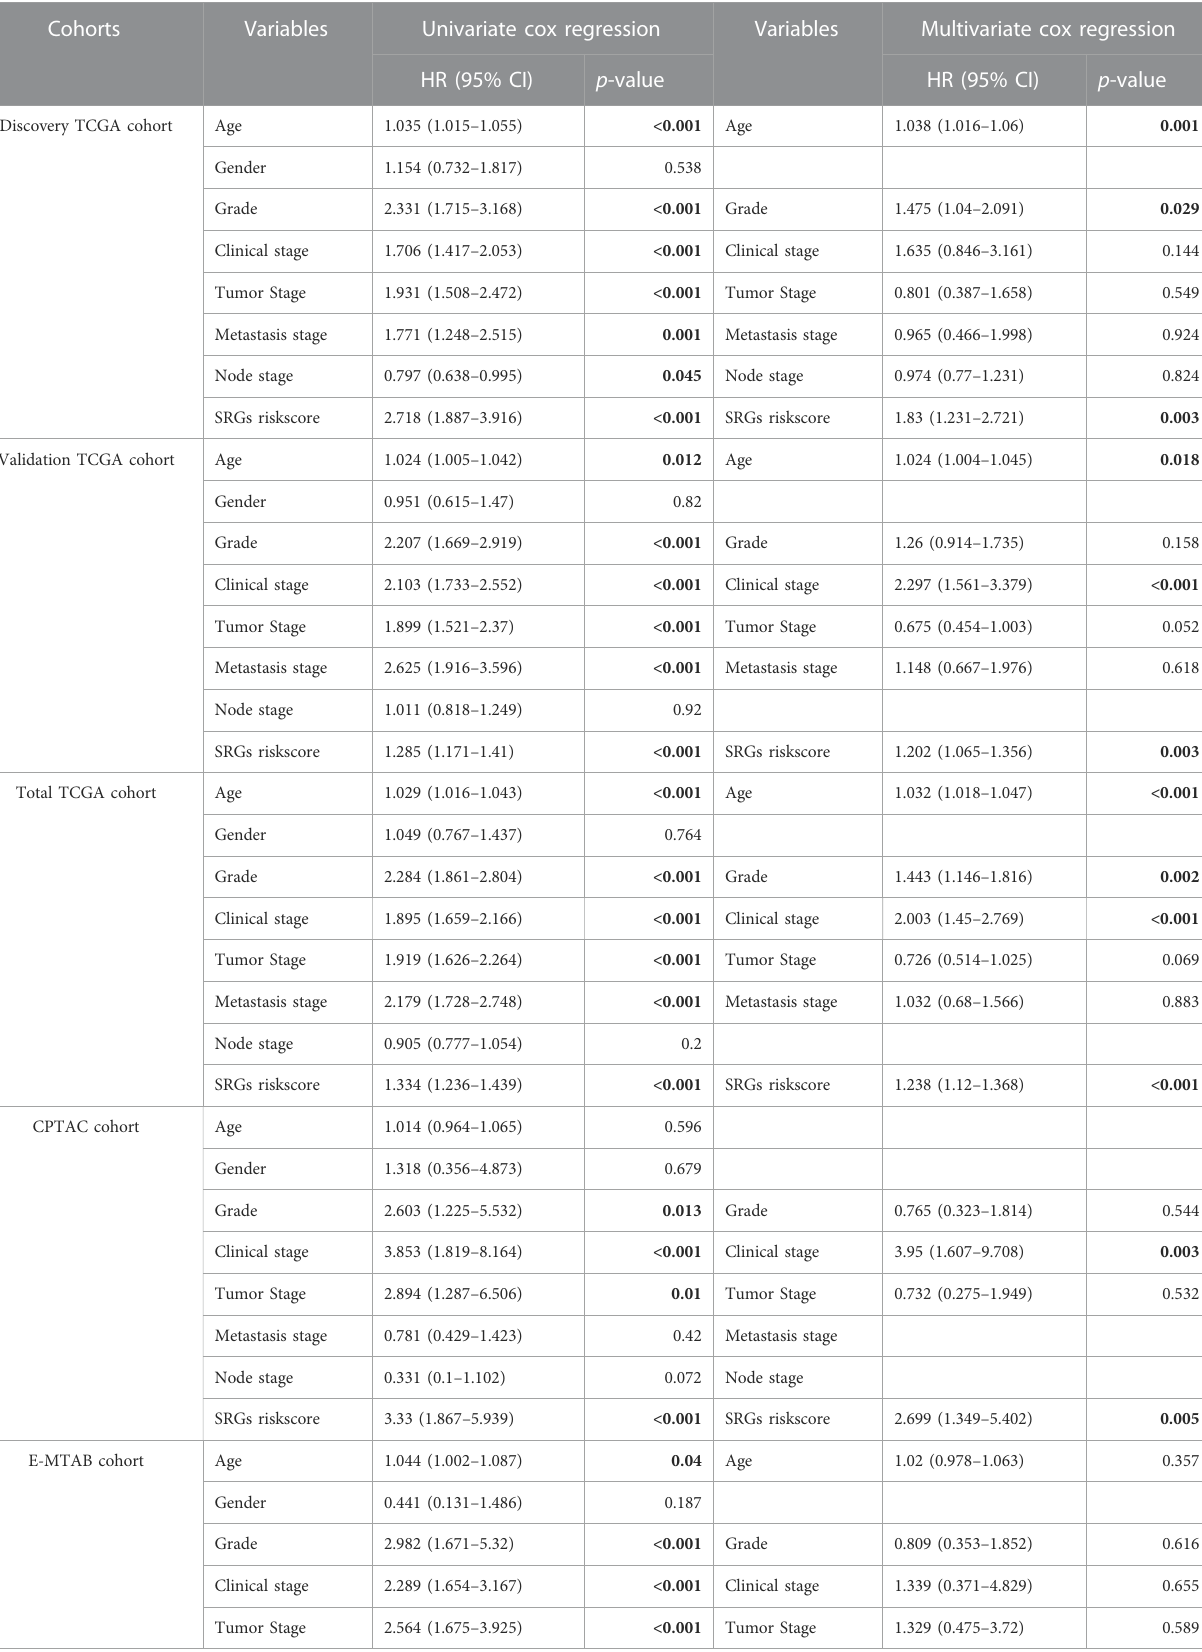
TABLE 2 Univariate and Multivariate Cox regression reveals riskscore is an independent risk factor in kidney